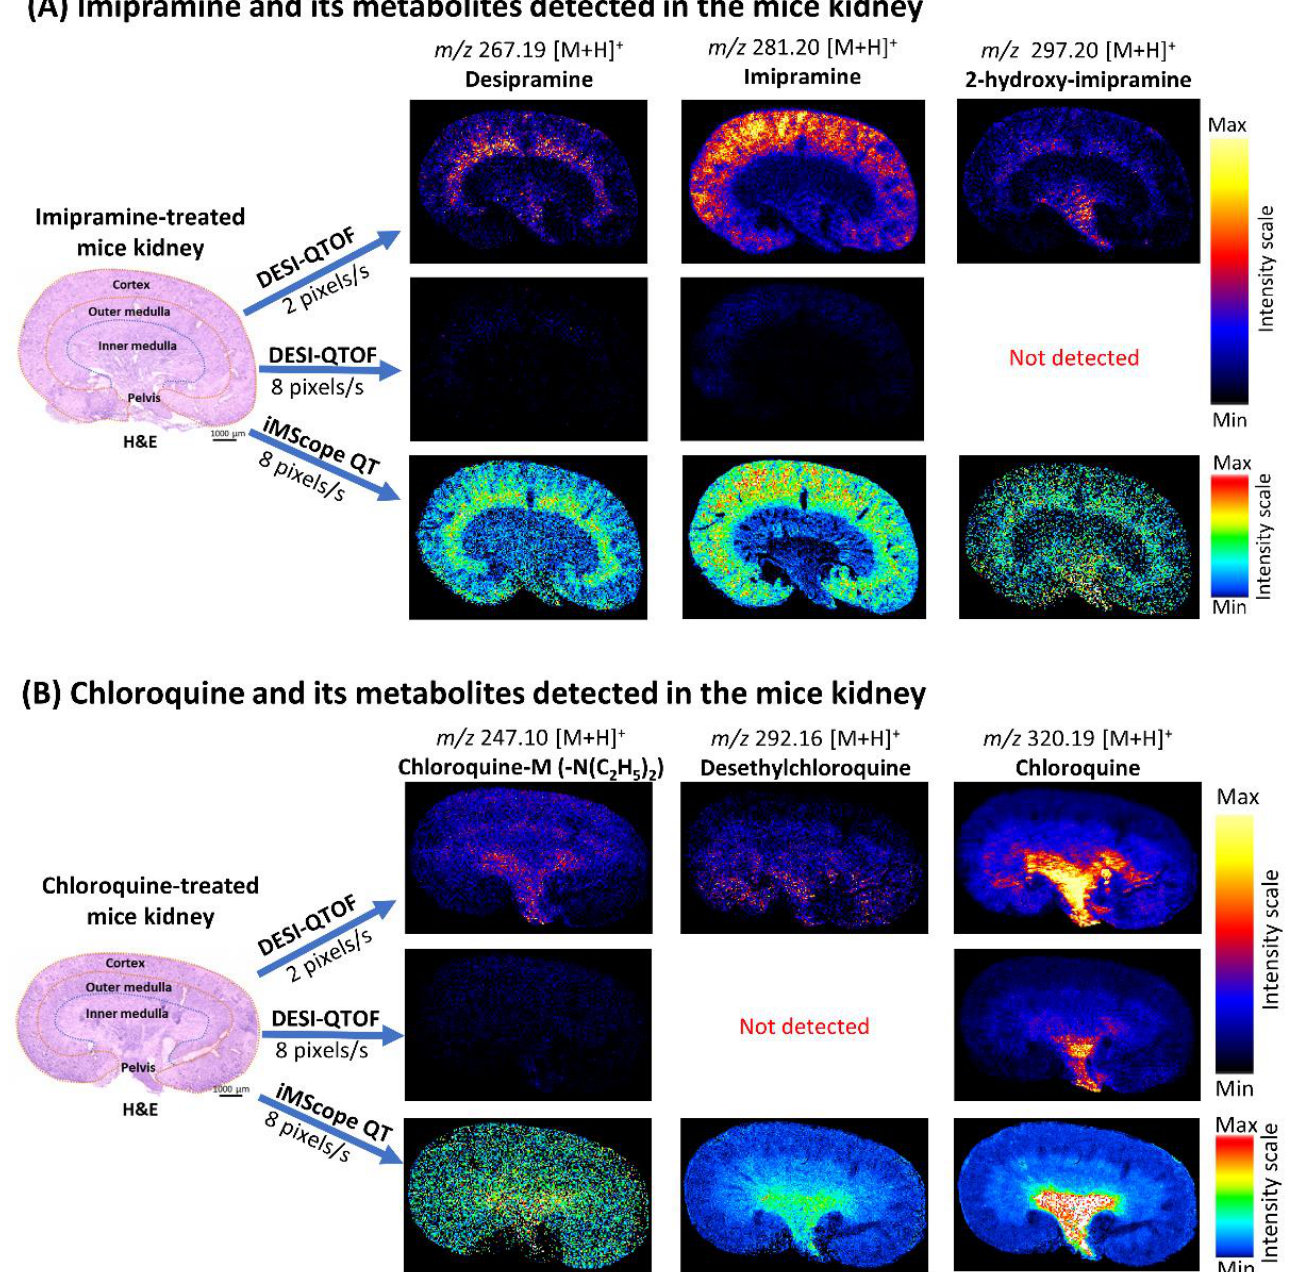
Figure 3 . Localization of imipramine, chloroquine, and their metabolites in the kidney of treated mice applying DESI-QTOF and iMScope QT at different data acquisition speeds. ( A ) Distribution of imipramine and its metabolites in the treated mice kidney. ( B ) Distribution of chloroquine and its metabolites in the treated mice kidney. Here, spatial resolution was 50 µ m × 50 µ m (X,Y), and CHCA was used as the matrix for iMScope QT samples. s: second.